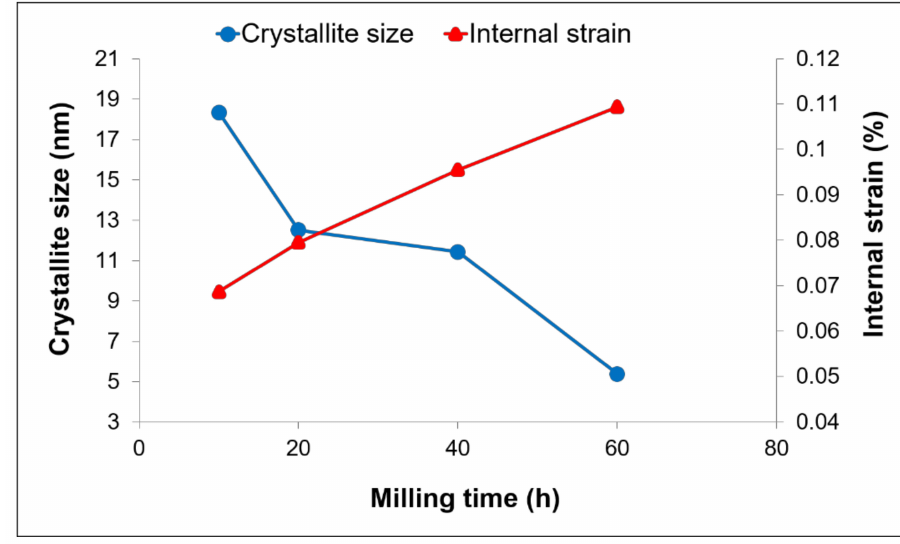
Figure 2. Cu crystallite size and internal strain of Cu-W-C powder for various milling time.